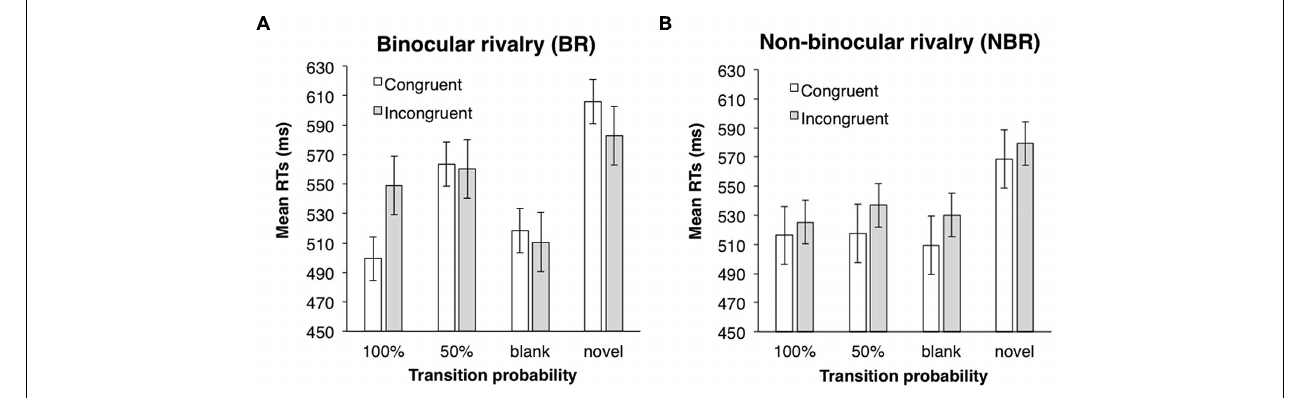
FIGURE 5 | Mean RTs of target detection in Experiment 3. (A) BR condition. (B) NBR condition.White bars indicate the mean RTs in the congruent eye condition; gray bars indicate the mean RTs in the incongruent eye condition. Error bars represent SE.